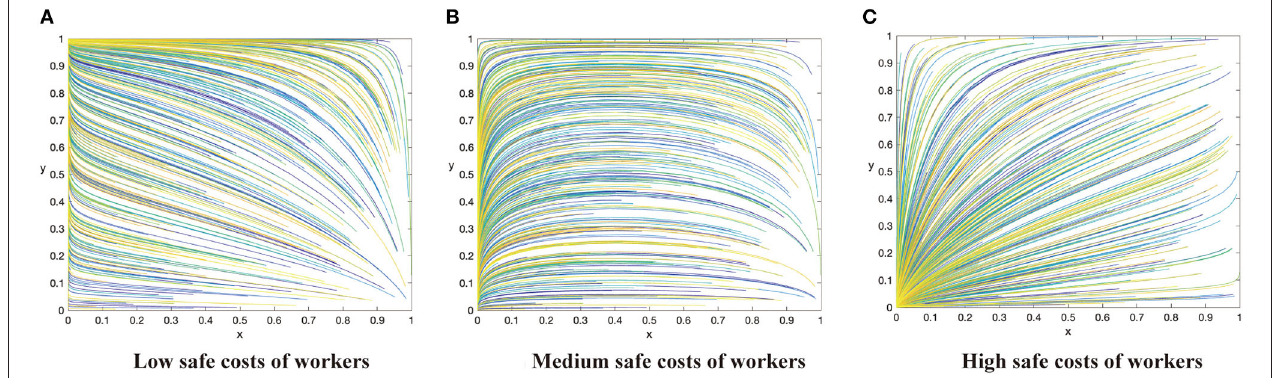
FIGURE 2 | The dynamic evolutionary path of the game in category 2, including low safety costs to workers (A) , high safety costs to workers (C) , and medium safety costs to workers (B) .